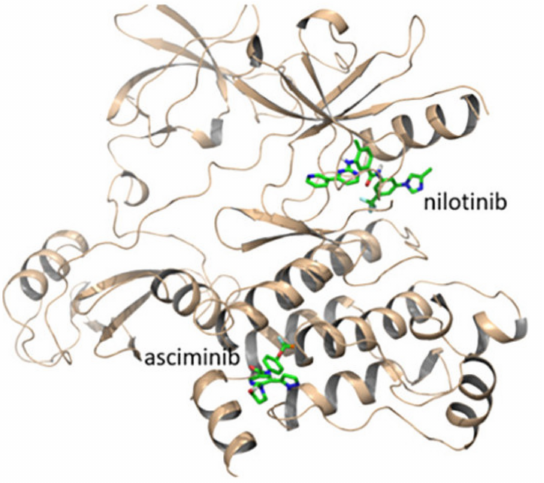
Figure 22. Comparison between the binding sites of asciminib and nilotinib